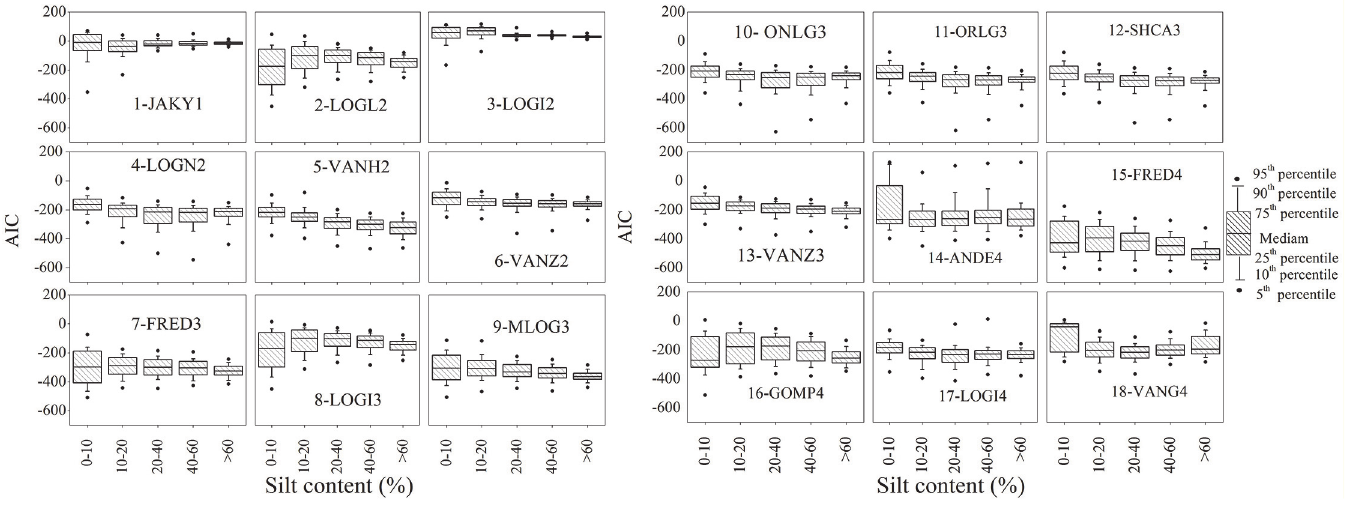
Fig 7. Box plots showing model performance with varying silt content of